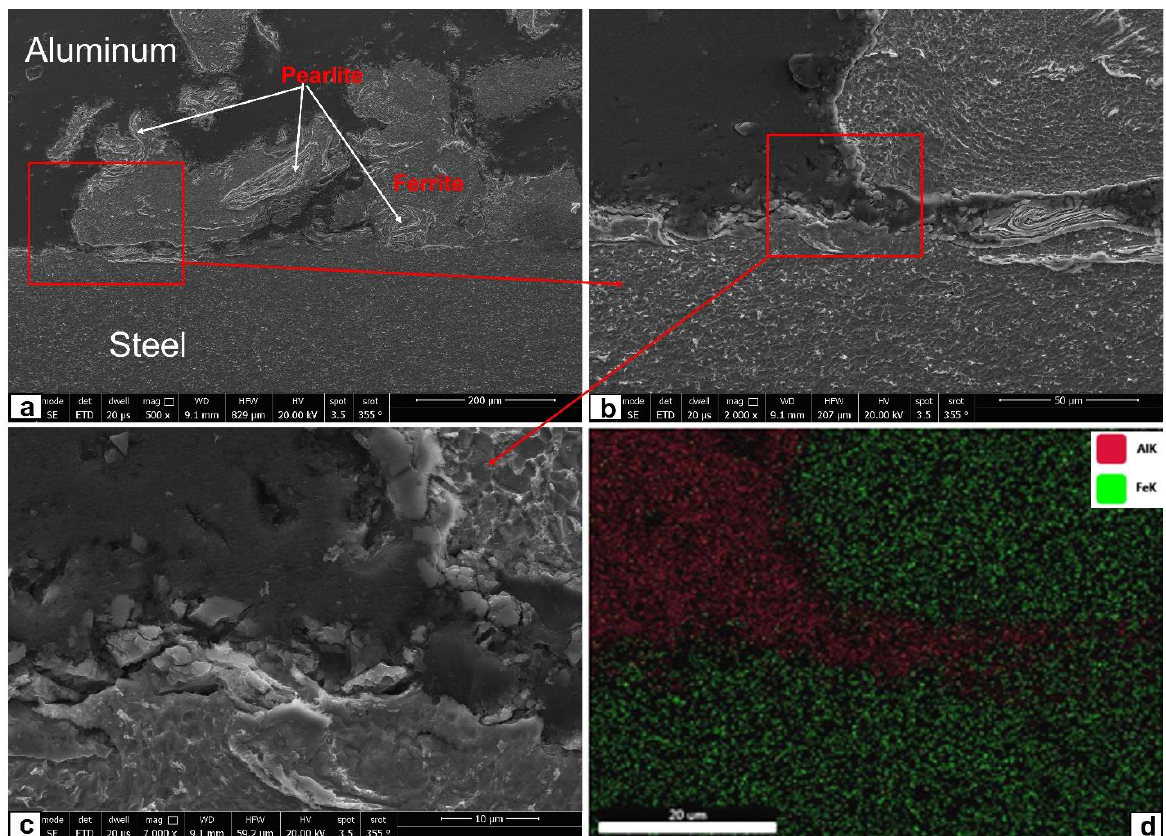
Figure 8. SEM Micrographs of the aluminum/steel interface produced with medium FSP rotation speed of 1000 rpm and pin length of 3 mm: ( a ) steel–aluminum interface, ( b ) magnified area in ( a ), ( c ) magnified area in ( b ), and ( d ) EDS mapping of ( c ).